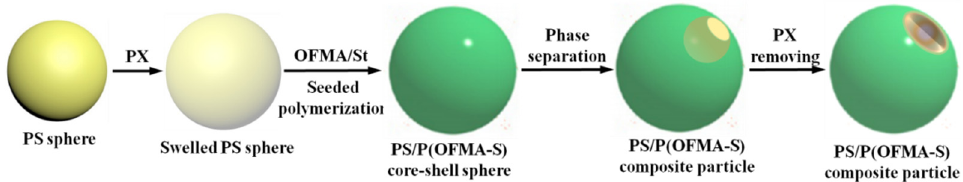
Figure 1. Synthesis of dimpled PS/P(OFMA-S) particles via seeded emulsion polymerization.